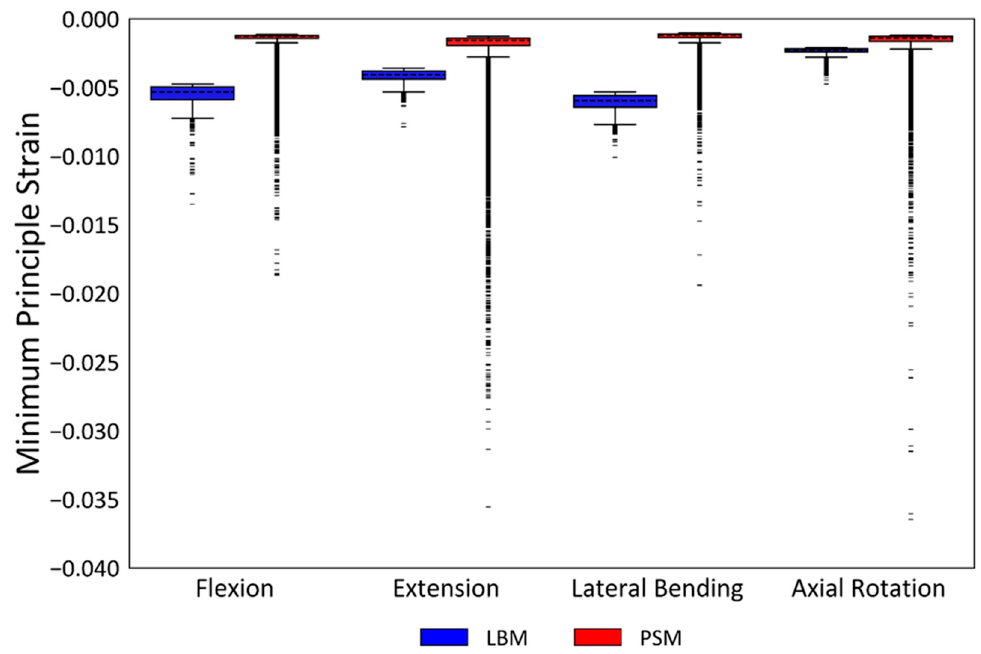
Figure 8. The boxplot figure includes 1% of the nodes with the highest compressive strain values of LBM and PSM bony